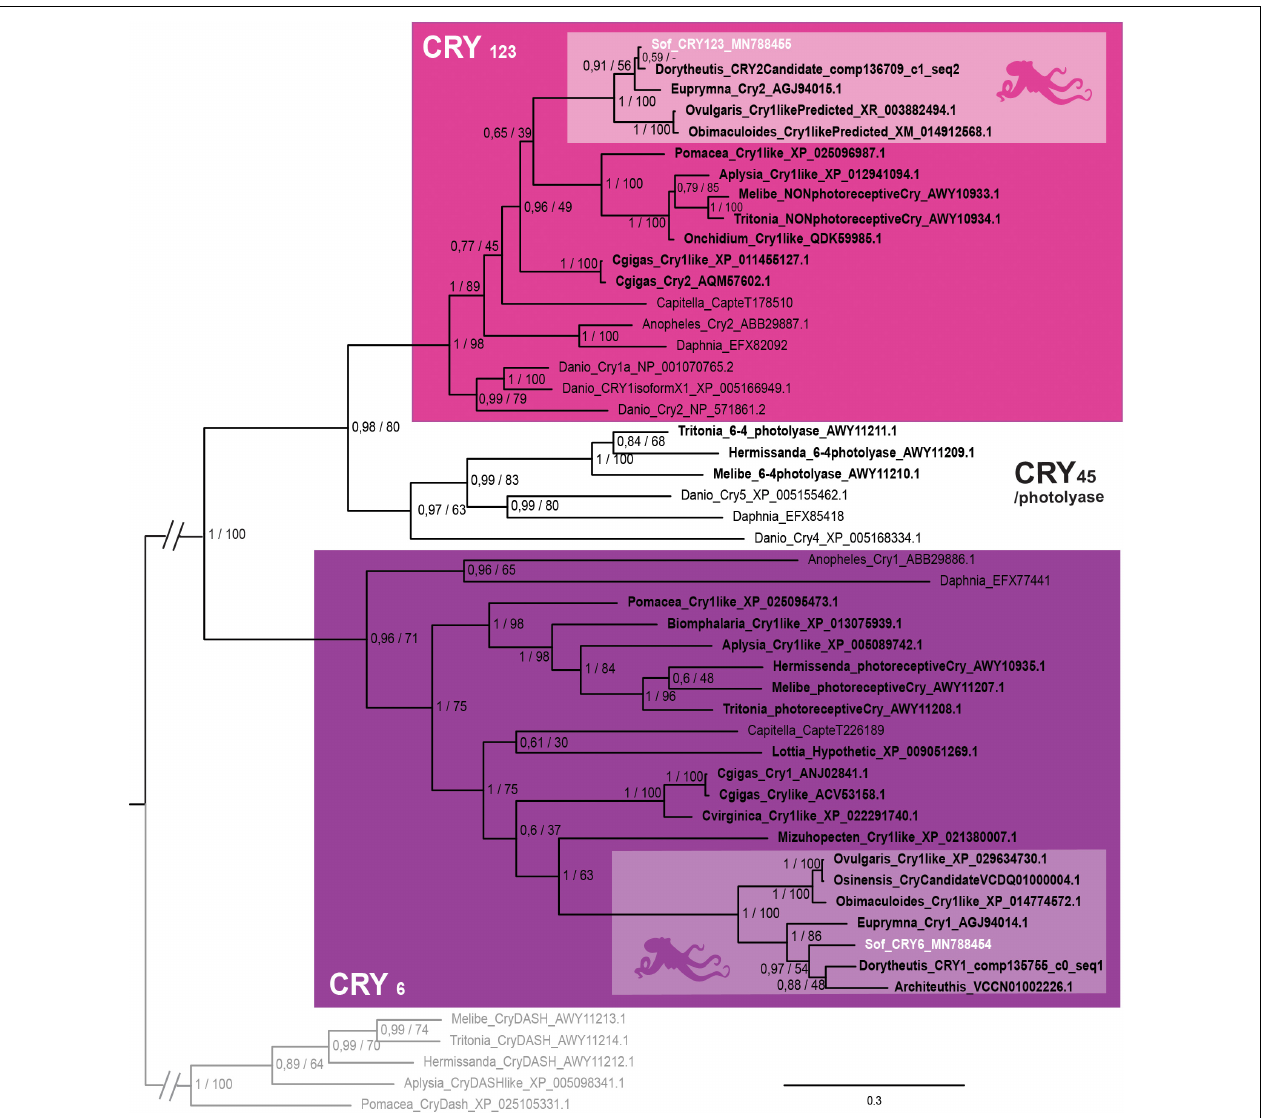
FIGURE 4 | Cryptochrome phylogeny. Phylogenetic analysis of 50 sequences of 402 amino acids generated in Bayesian Inference (Mr. Bayes v3.2.7a). Three main groups of animal cryptochromes are retrieved: CRY 123 , CRY 45 /Photolyase and CRY 6 . Sequences from S. officinalis are in white, sequences from other molluscs are in bold font and outgroups used for rooting the tree (CRY-DASH) are in gray. Nodes labels are posterior probabilities and bootstrap values (PP/BS). Lighter boxes with cephalopod silhouette [modified from Stöger et al. (2013)] represent groups of cephalopod sequences. The branch from the root to the ingroups and outgroups were shortened for more lisibility